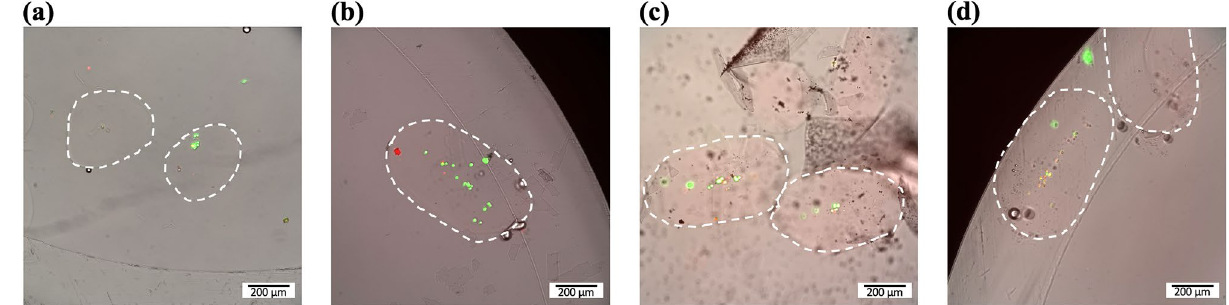
Figure 5. Hydrogel droplets with encapsulated astrocytes after cross-linking and washing (a) Without the acoustics applied the cells are randomly positioned in the hydrogel droplets. The photo is taken after 7 days of cell culture. (b–d) With the acoustics applied the cells are focused along the centre line of the hydrogel droplets. (b) shows the cells after 1 day of culture, (c) shows the cells after 3 days of culture and (d) shows the cells after 7 days of culture. The dashed lines indicate the border of the hydrogel droplets. Living cells stained with calcein appear green whereas dead cells stained with propidium iodide appear